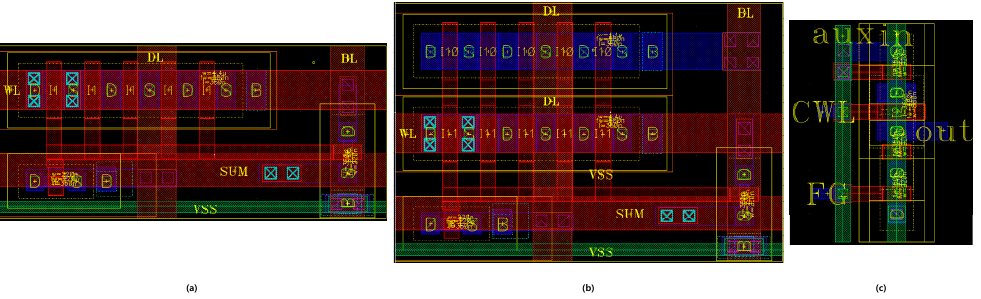
Figure 10. Layout of the unit cells in ( a ) 2C-1T, ( b ) 3C-1T, and ( c ) CTT with an auxiliary path.